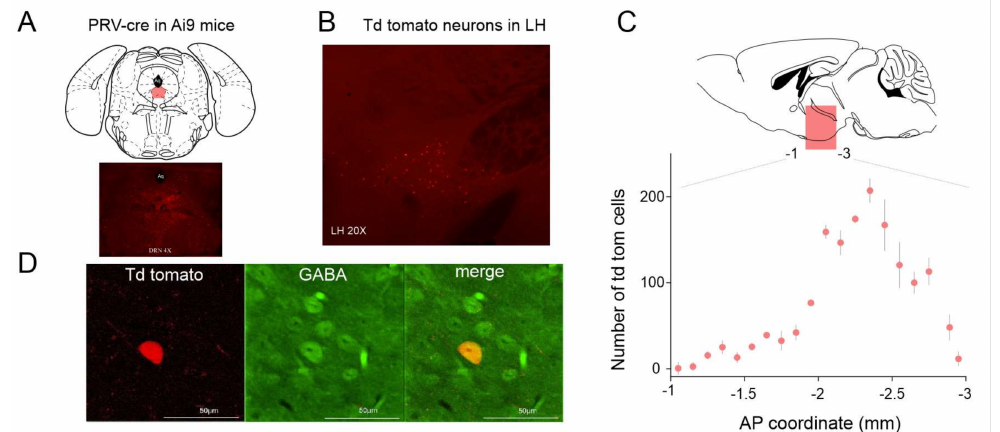
Figure 1. Projections from LH (lateral hypothalamus) to DRN (dorsal raphe nucleus). ( A ) Schematics of the experimental design for retrograde labeling of LH neurons projecting to the DRN. ( B ) Coronal section of a mouse brain at the level of the LH shows tdTomato expression following PRV-cre injection in the DRN. ( C ) Distribution of the tdTomato expressing somata in the LH. AP: anteroposterior. ( D ) Immunohistochemical labeling of GABAergic